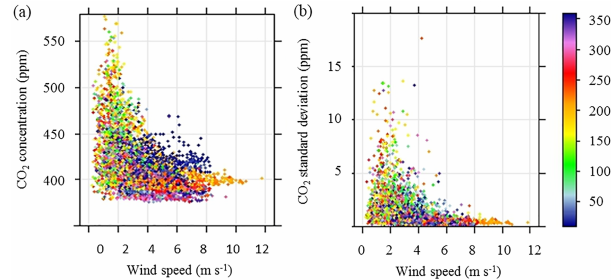
Figure 9. (a) Hourly means of the CO 2 concentration recorded at GON (NE peri-urban site, 4ma.g.l.) as a function of wind speed and colored by wind direction (the color scale is in degrees). (b) Same for the CO 2 standard deviation (1 σ of the hourly CO 2 concentration